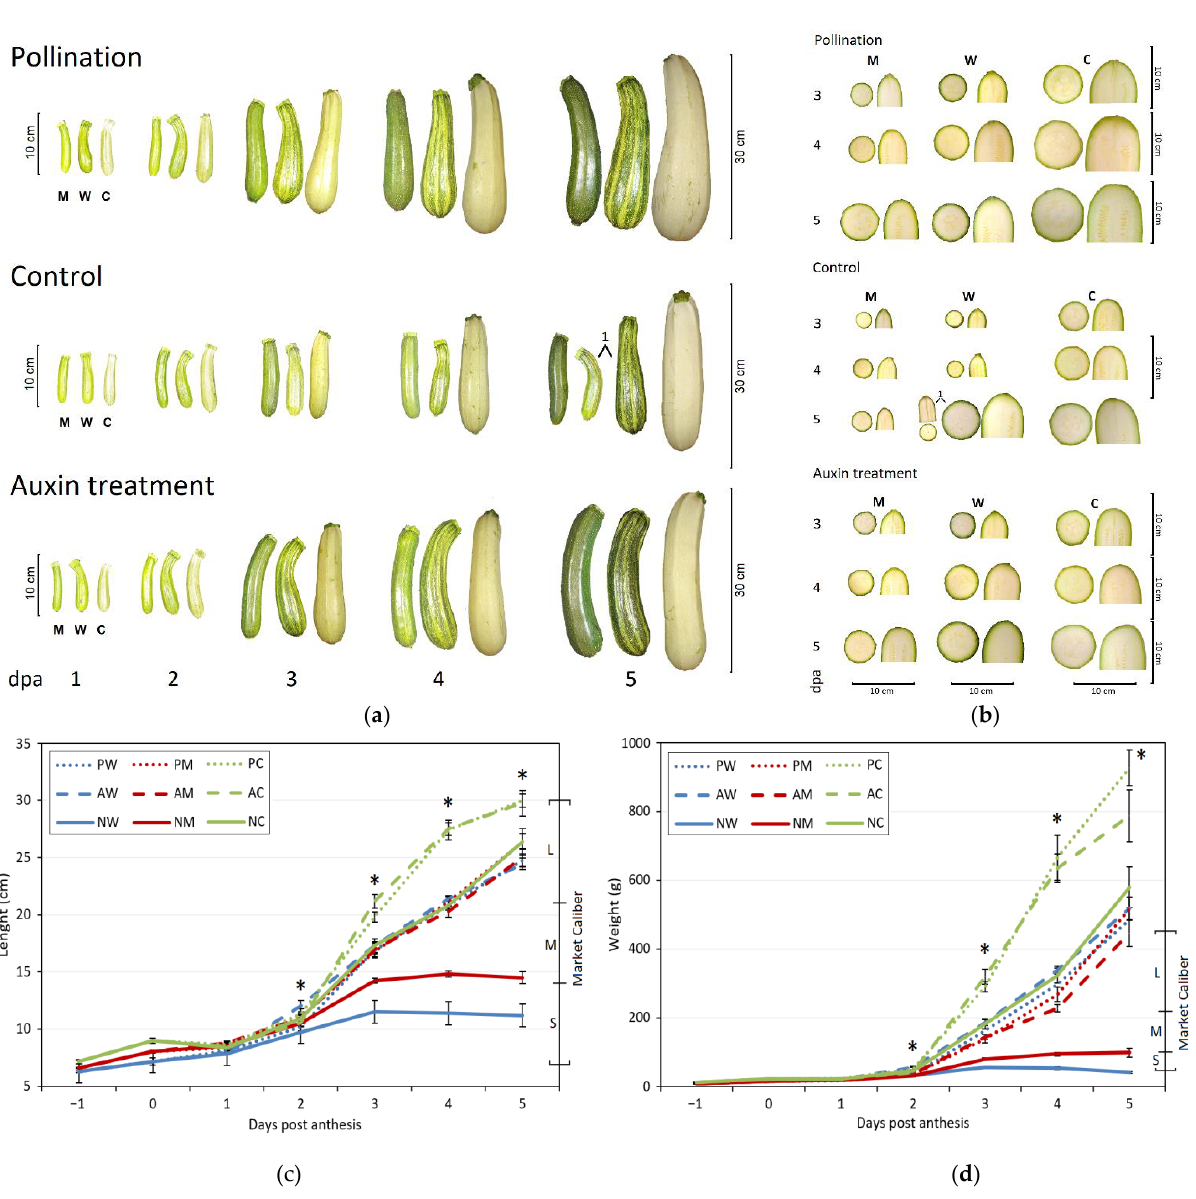
Figure 1. Morphological changes in Cavili, MUCU-16, and Whitaker genotypes after auxin, pollination, and control treatments for 5 days post anthesis. Whole fruit ( a ) and central (transversal cut) and stylar (longitudinal cut) sections ( b ). 1 In Whitaker, both phenotypes were found, mostly the smallest phenotype (84%). Mean length ( c ) and weight ( d ) of each sample for 5 dpa with the market standards categorized in S (small: 7 – 14 cm; 50 – 100g), M (medium: 14 – 21 cm; 100 – 225 g) and L (large: 21 – 30 cm; 225 – 450 g). Pollinated (P), Auxin-treated (A), Non-treated (N) Whitaker (W), MUCU-16 (M) and Cavili (C) genotypes. * Significative differences between samples ( p < 0.005). Error bars are standard errors (n ≥ 8).